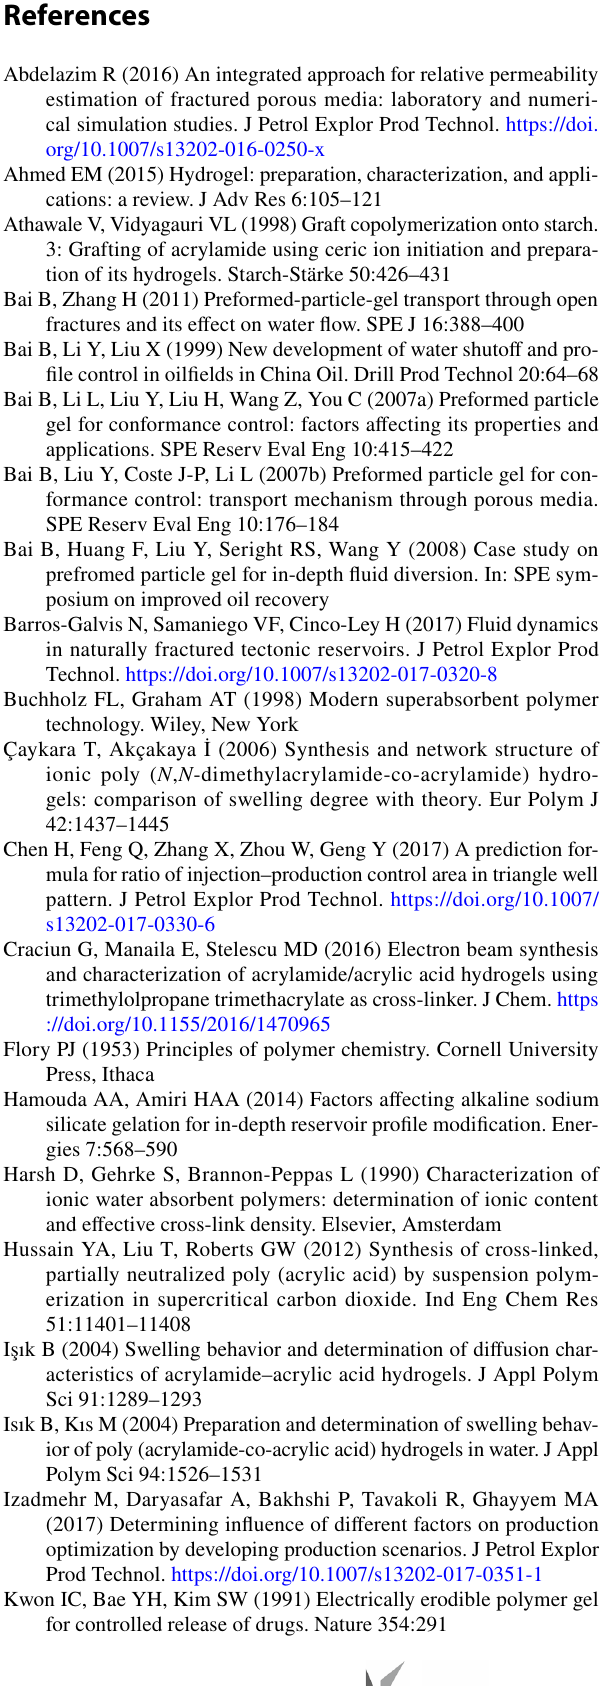
2 ·2H 2 O salt solutions